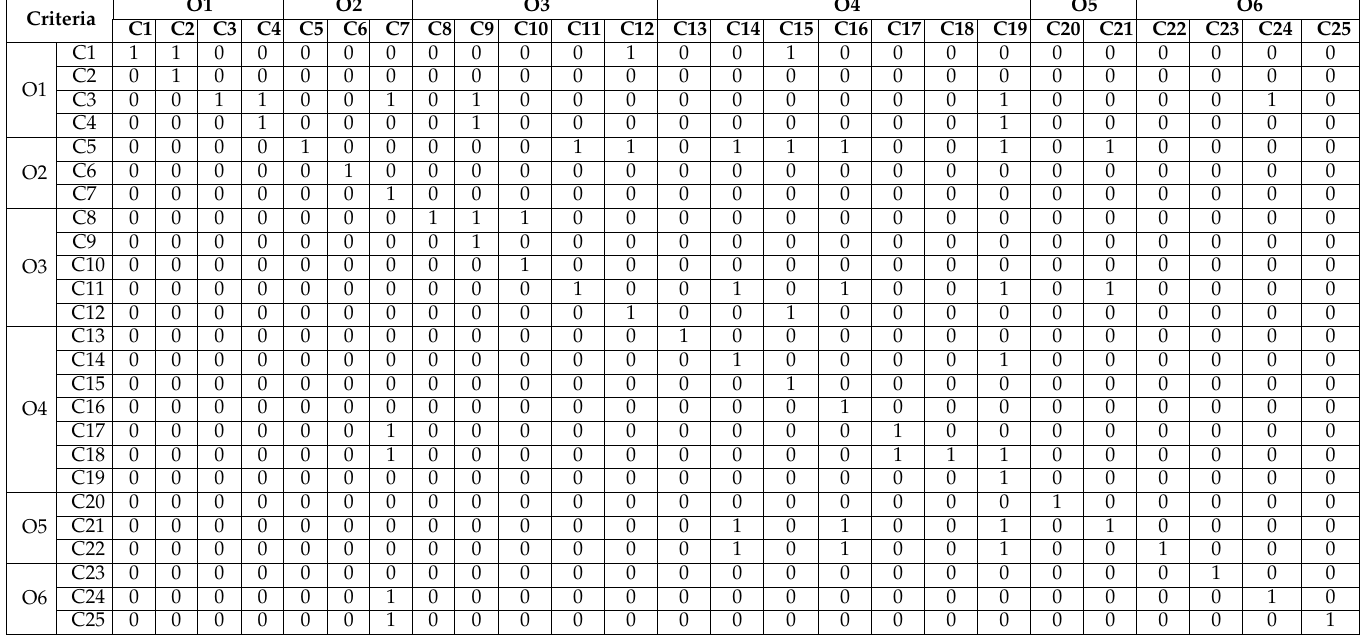
Table 7. The reachable matrix of criteria.